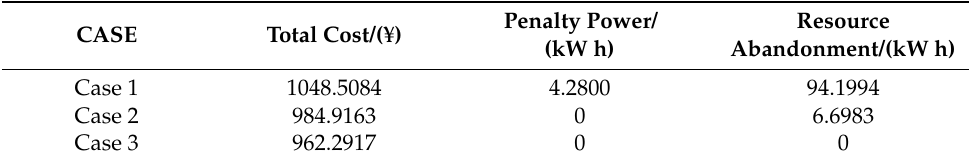
Table 2. Results of costs in different